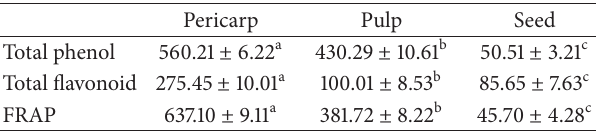
Values represent means ± standard deviation of triplicate readings. Values with the same superscript letter along the same row are not significantly different ( 𝑃 > 0.05 ).